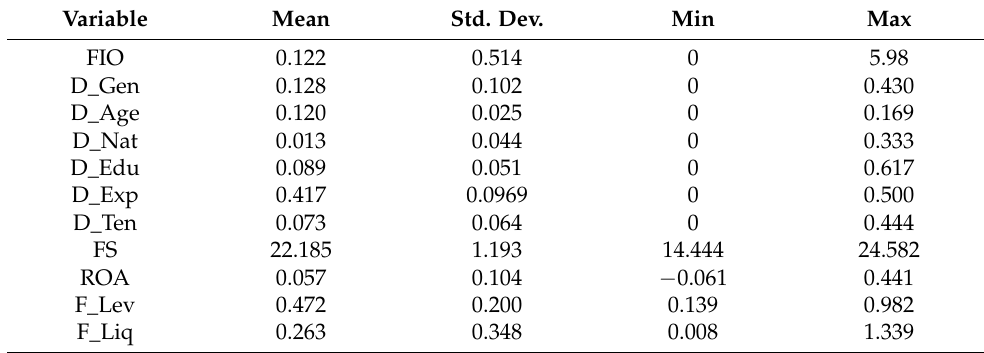
Table 2. Summary of the collected